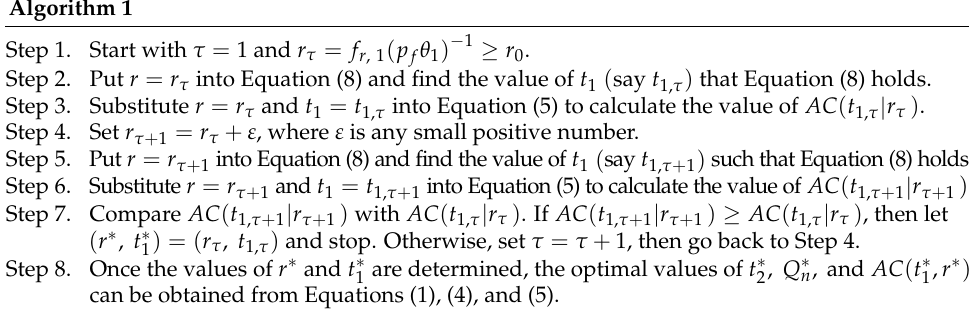
Algorithm 1 for finding the optimal solution ( t ∗ Algorithm